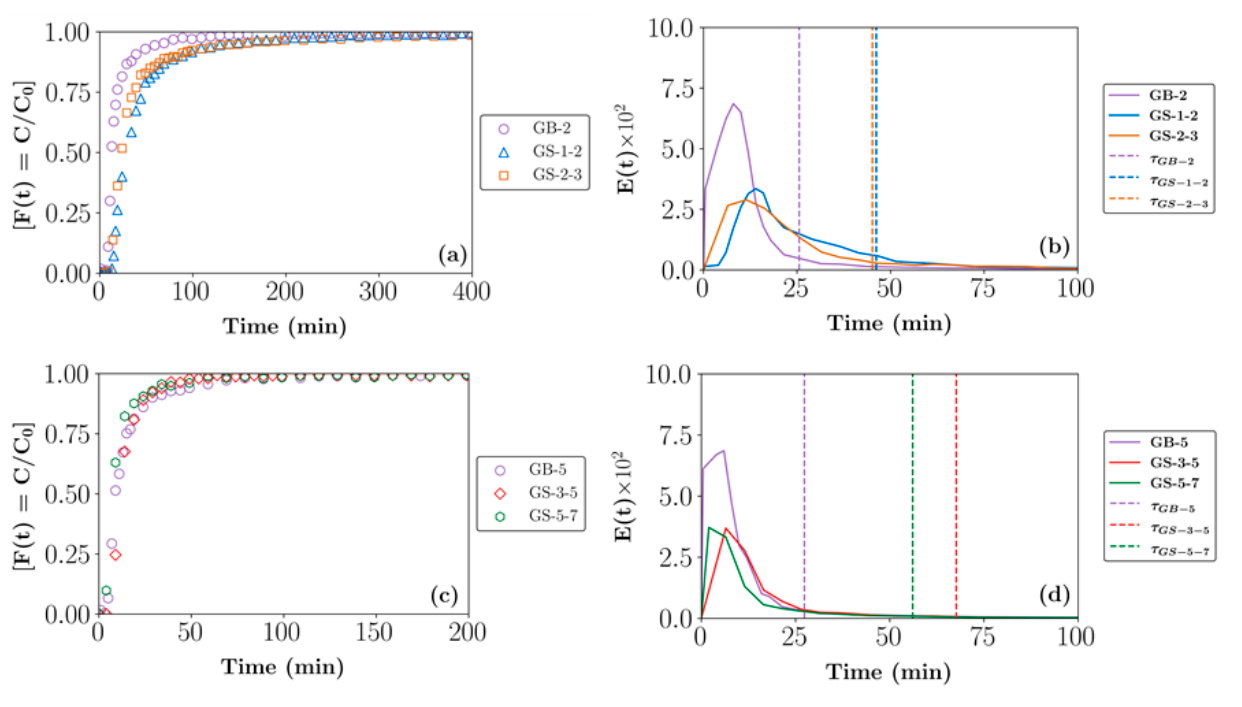
Figure 7. (Left—( a , c )) Cumulative (F(t)) and (right—( b , d )) exit age (E(t)) RTD profiles for beds composed of different size fractions of glass beads (GBs) and glass shards (GSs). Key: GB-2 (2 mm), GB-